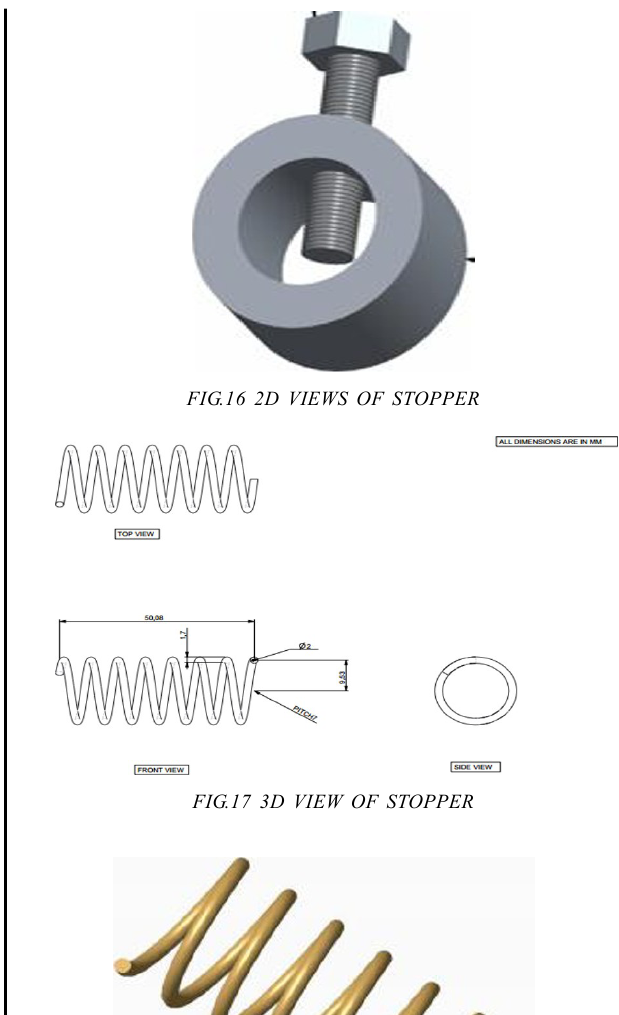
FIG.13. 2D VIEWS OF ROUND NYLON